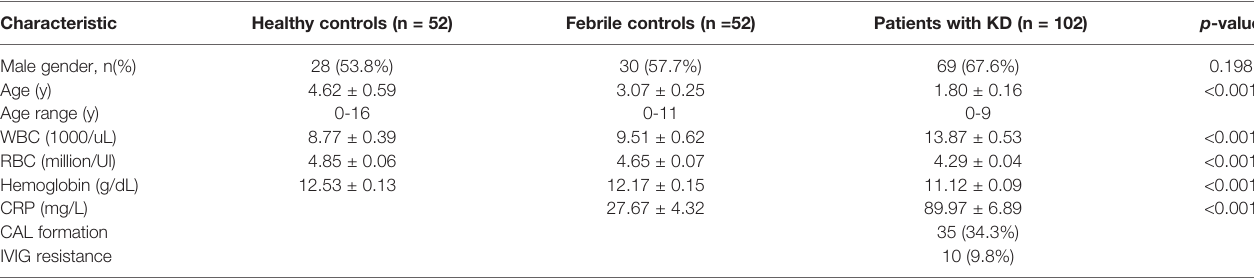
CAL, coronary artery lesion; IVIG, intravenous immunoglobulin; KD, Kawasaki disease. data expressed as mean ±